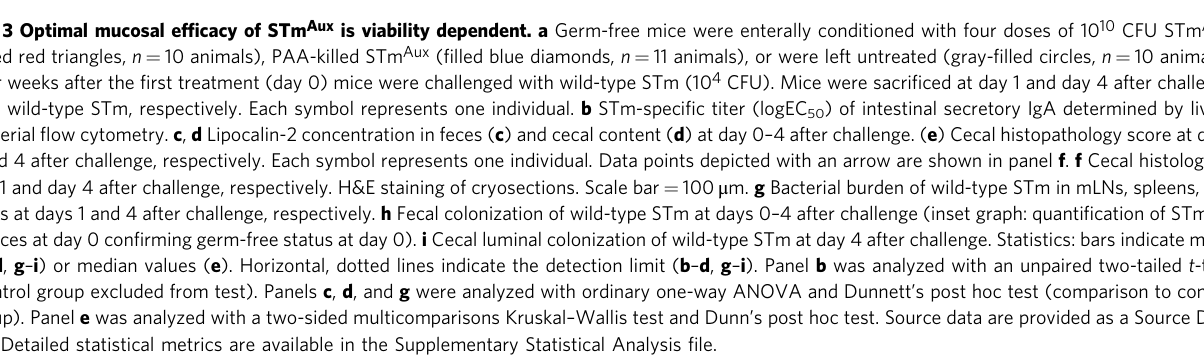
Fig. 3 Optimal mucosal ef fi cacy of STm Aux is viability dependent. a Germ-free mice were enterally conditioned with four doses of 10 10 CFU STm Aux ( fi lled red triangles, n = 10 animals), PAA-killed STm Aux ( fi lled blue diamonds, n = 11 animals), or were left untreated (gray- fi lled circles, n = 10 animals). Four weeks after the fi rst treatment (day 0) mice were challenged with wild-type STm (10 4 CFU). Mice were sacri fi ced at day 1 and day 4 after